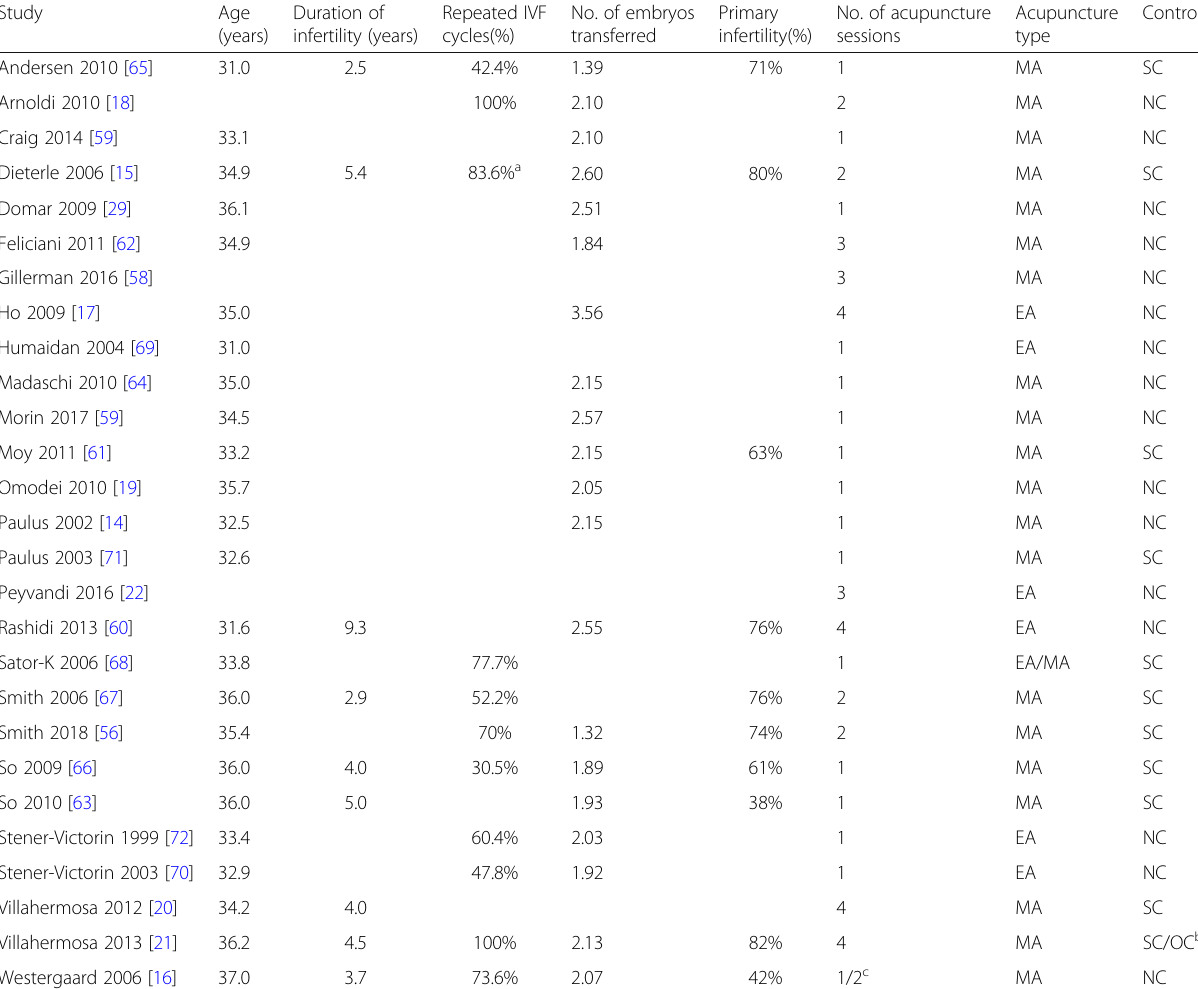
Table 2 The information of variables for meta-regression subgroup analyses Study Age